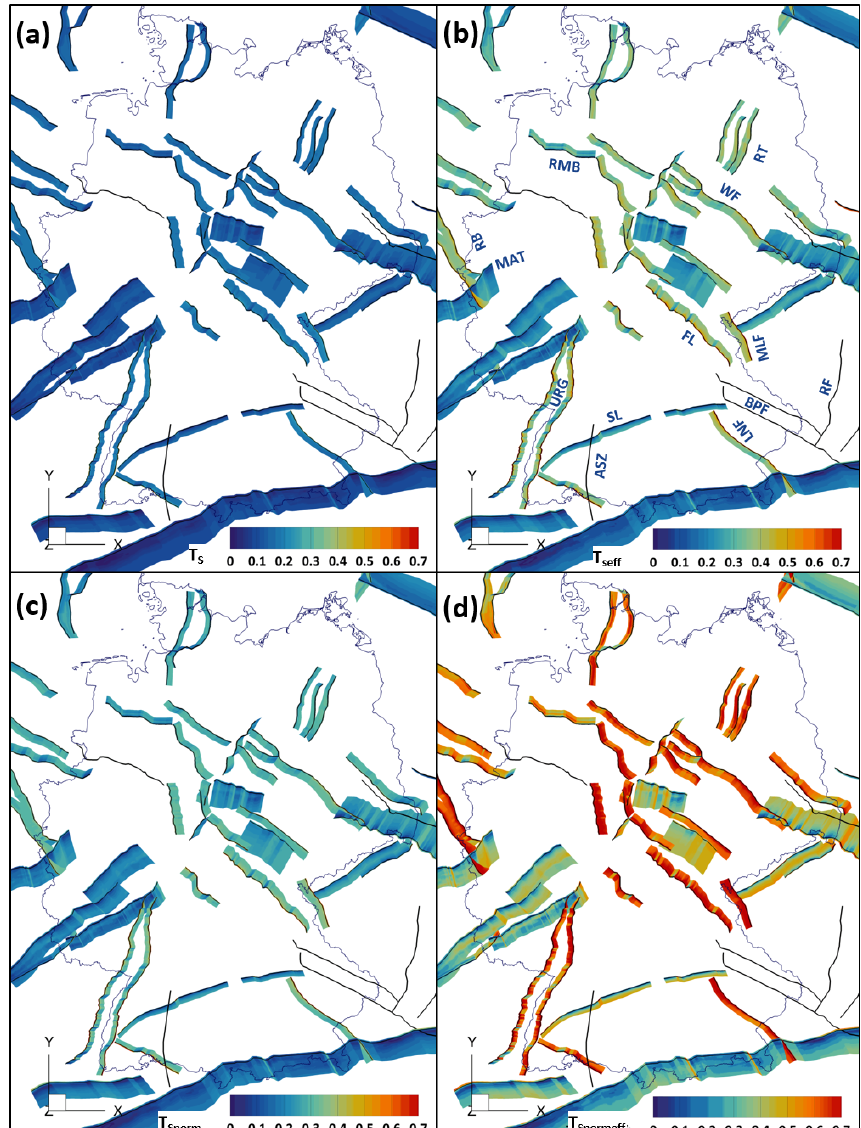
Figure 3. Top view of the slip tendency of the Andersonian fault set calculated for four slip tendency types. (a) T S ; (b) T Seff (with effective normal stresses); (c) T Snorm (normalized to a coefficient of friction of 0.57); (d) T Snormeff (with effective normal stresses and normalized to a coefficient of friction of 0.57). ASZ: Albstadt Shear Zone; BPF: Bavarian Pfahl Fault; FL: Franconian Line; LNF: Landshut–Neuötting Fault; MAT: Midi-Aachen Thrust; MLF: Mariánské Lázne Fault; URG: Upper Rhine Graben; RB: Roer Basin; RT: Rheinsberg Trough; RF: Rodl Fault; RMB: Rheder Moor–Blenhorst Fault; SL: Swabian Lineament; WF: Wittenberg Fault. ©EuroGeographics for the administrative